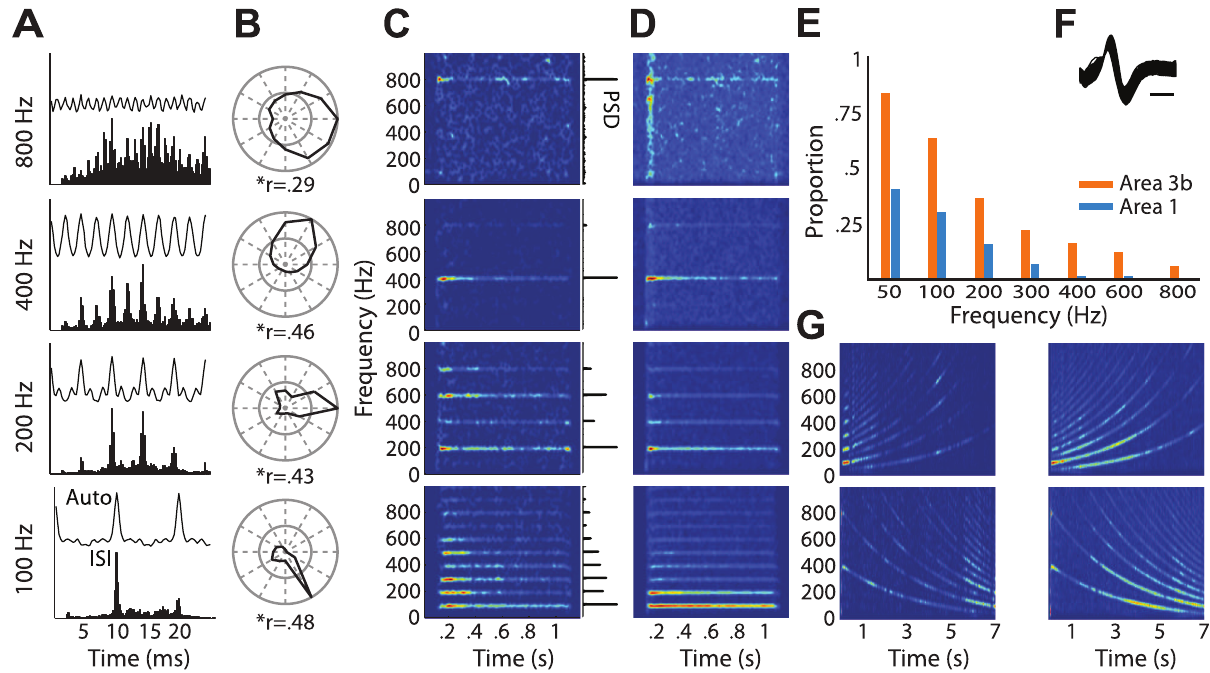
Figure 2. Temporal patterning in cortical responses to sinusoidal stimulation. (A) Autocorrelations (top) and interspike interval histograms (bottom) for one neuron in area 3b, whose responses are entrained with the stimulus up to 800 Hz. (B) Phase histograms along with vector strength (r) for the same neuron as in (A) showing action potentials tended to occur during a restricted phase of each stimulus cycle. (C) Spectrograms for the same neuron as in (A), with corresponding power spectral densities (PSD) in the insets to the right. Note that the temporal patterning begins almost immediately and lasts for the duration of the stimulus, and that the fundamental frequency in the neural response reflects the frequency of the sinusoid. (D) Average spectrograms computed from the population of neurons that exhibited significantly phase-locked responses above 200 Hz (11 neurons in area 3b, five neurons in area 1). (E) Proportion of neurons in areas 3b and 1 that produced phase-locked responses at each frequency tested. (F) Traces of 1,000 action potential waveforms for the neuron whose responses are shown in (A–C); scale bar=250 m s. (G) Spectrograms of neural responses to sine-sweep stimuli with either upward or downward sweeps between 50 and 400 Hz (left, same neuron as in (A); right, average over phase-locked